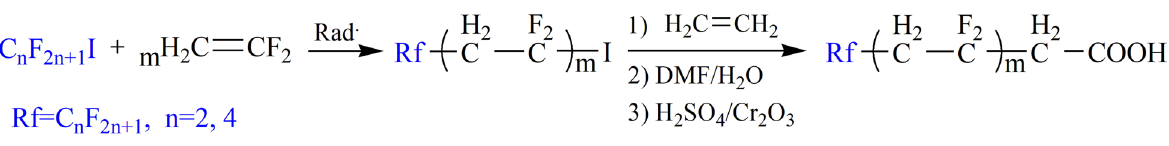
Scheme 3 The radical telomerization of VDF with C n F 2n+1 I to synthesize fluorinated surfactants